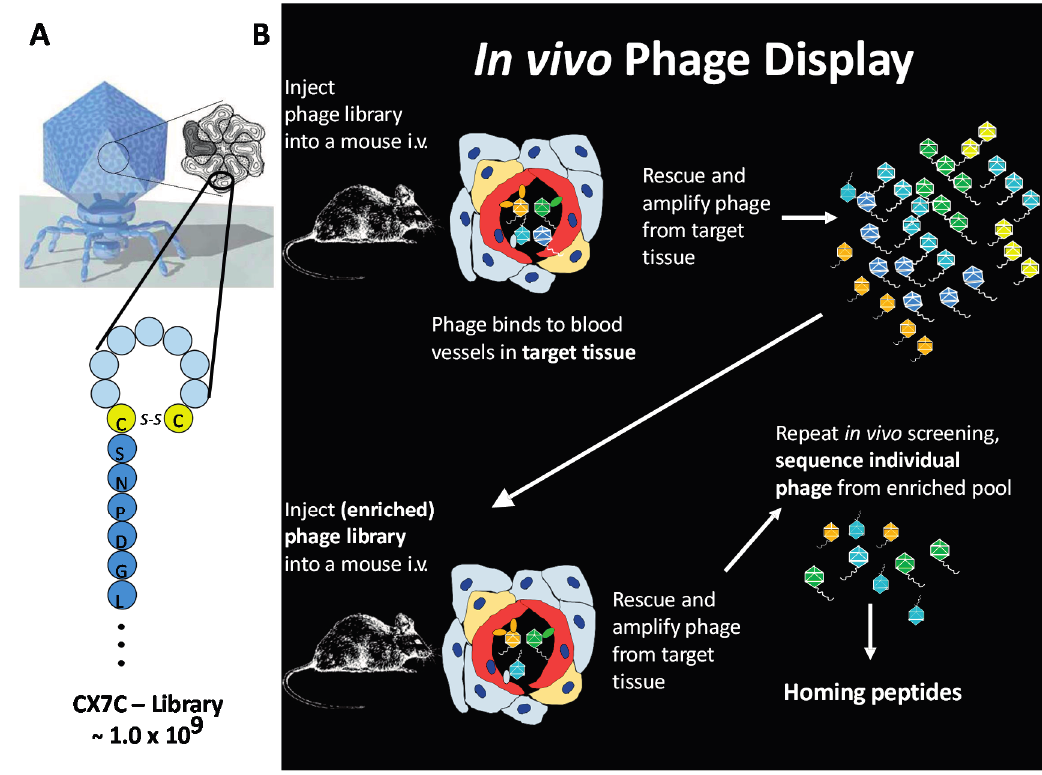
Figure 2. Schematic presentation of the principle of in vivo phage display. ( A ) A cyclic CX7C-peptide library is cloned onto the C-terminus of phage coat protein and 415 copies expressed per T7 phage via Select 415-1b; and ( B ) the phage library is injected into the circulation. As the homing peptides on the phage bind to endothelium in the tissues, there is an enrichment of phage that binds to the endothelium of the target tissue. Target tissue is homogenized, cell suspensions prepared, and the bound phage rescued and amplified by adding E. coli . The amplified phage pool recovered from the target tissue is re-injected into mice at a similar disease stage, and the screening cycle repeated several times to ensure phage clones that specifically bind ( i.e. , home) towards target are recovered. A set of phage clones is collected from the homing phage population that shows enrichment towards the target tissue. The peptide-encoding DNA inserts are amplified by PCR, and the PCR products sequenced. Modified from Ruoslahti